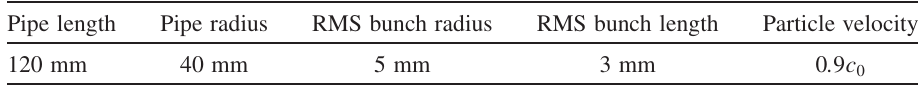
TABLE I. Settings of the benchmark example.